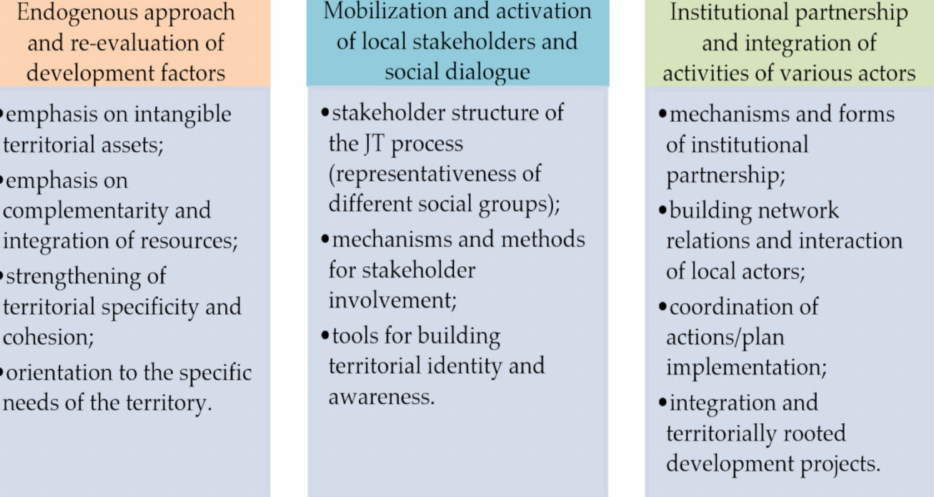
Figure 2. Areas of place-based policy analysis in the creation of a Territorial Just Transition Plan. Source: own